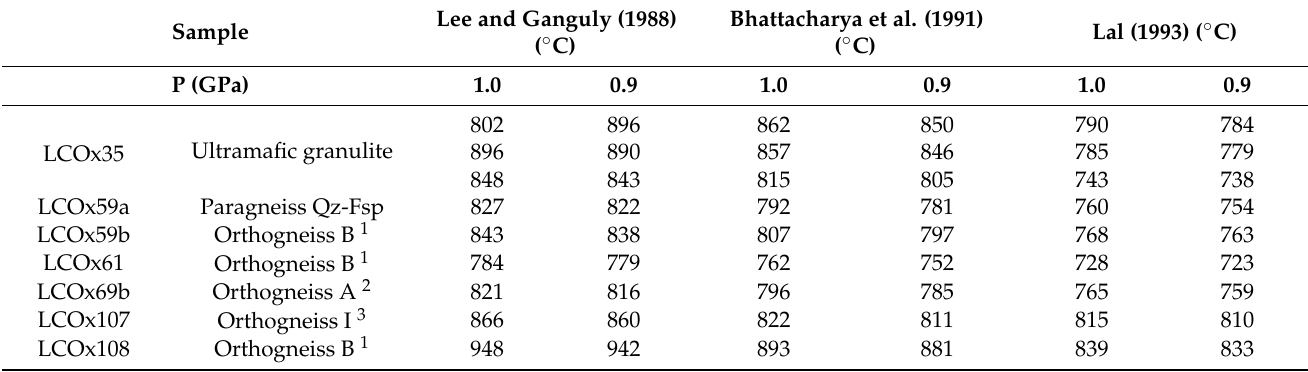
Table 3. Results of Grt-Opx geothermometer calibrations from [48–50] with two inputs of P: 0.9 GPa and 1.0